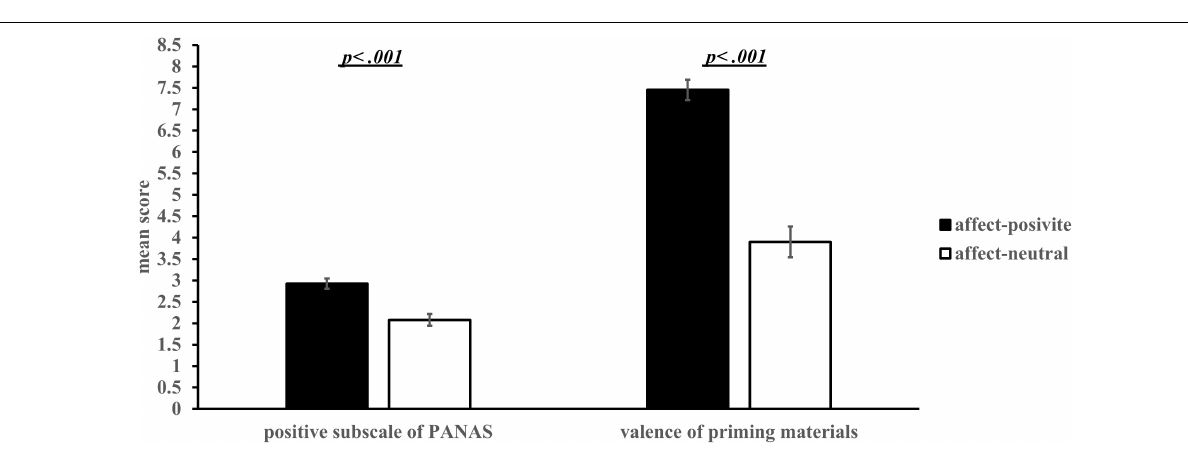
FIGURE 2 | Mean scores of positive subscale of PANAS and the evaluation for the valence of priming materials in different affect groups (M ± SE). The item for valence evaluation was “Did you feel happy when watching the video” using a nine-point Likert scale (1 = very unhappy, 9 = very